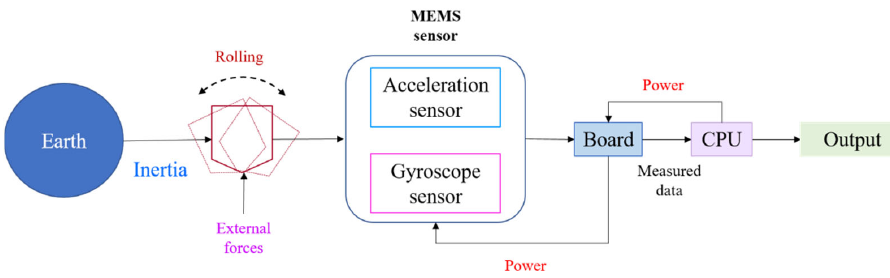
Figure 3. Detailed schematic of the experiment.